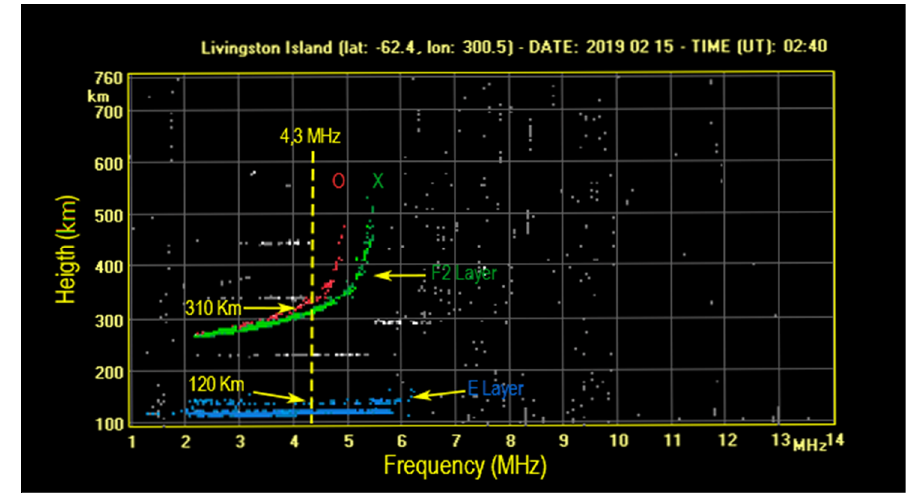
Figure 6. Ionogram of Livingston Island.